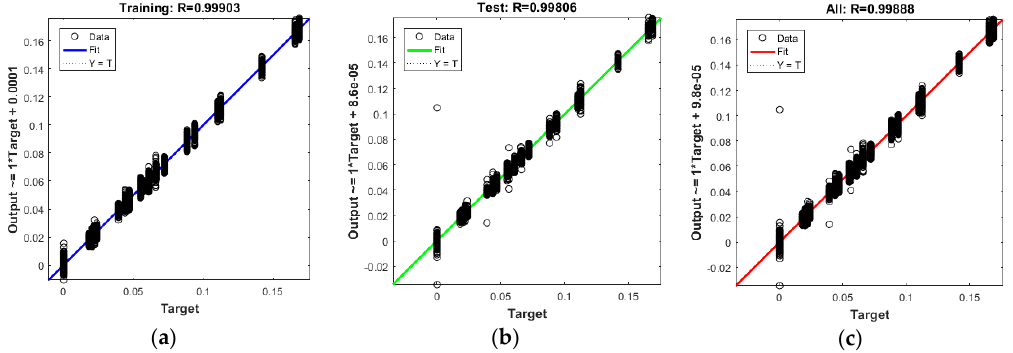
Figure 11. The best fit linear regression between outputs and targets for ( a ) Training data; ( b ) Test data; ( c ) All data.